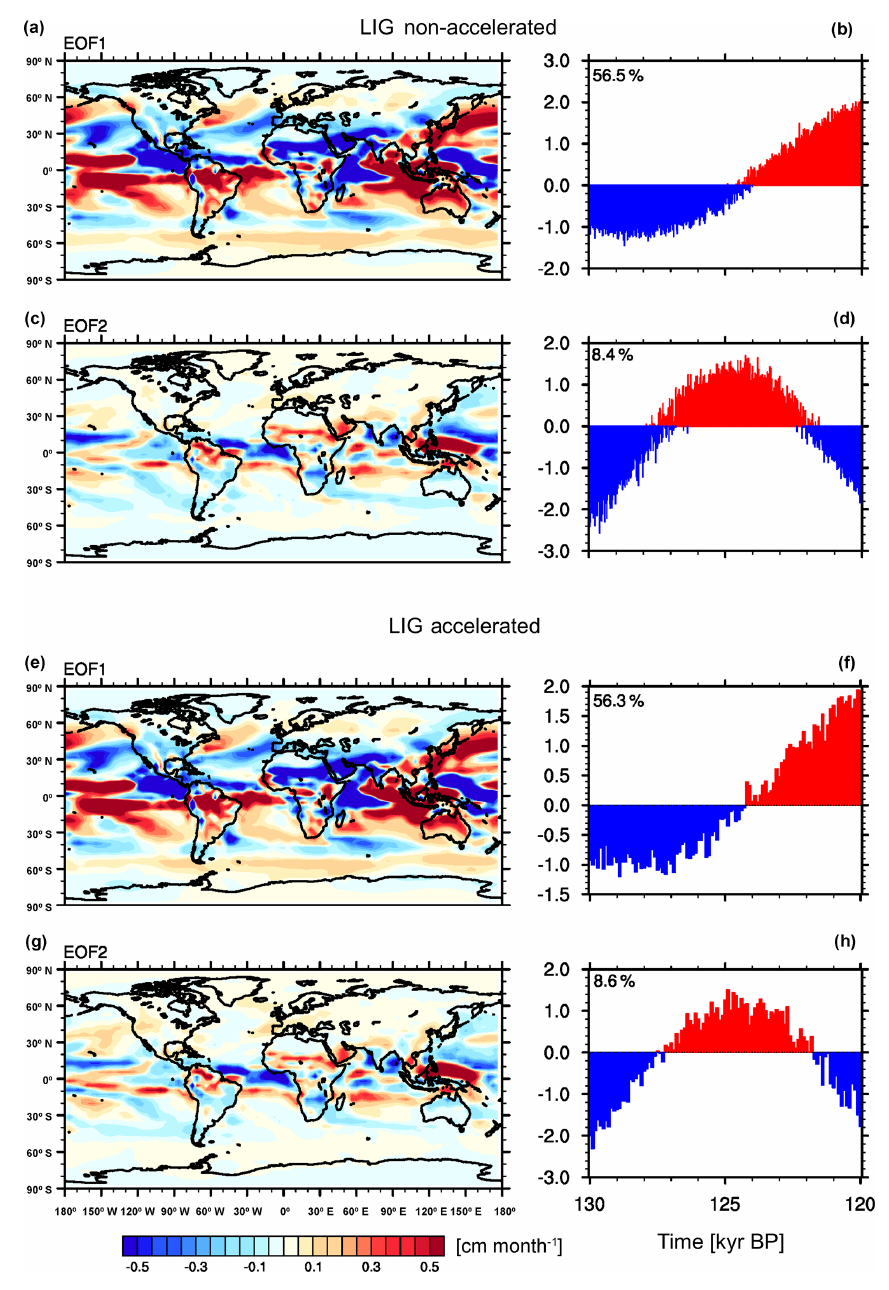
Figure 10. Same as Fig. 5 but for LIG